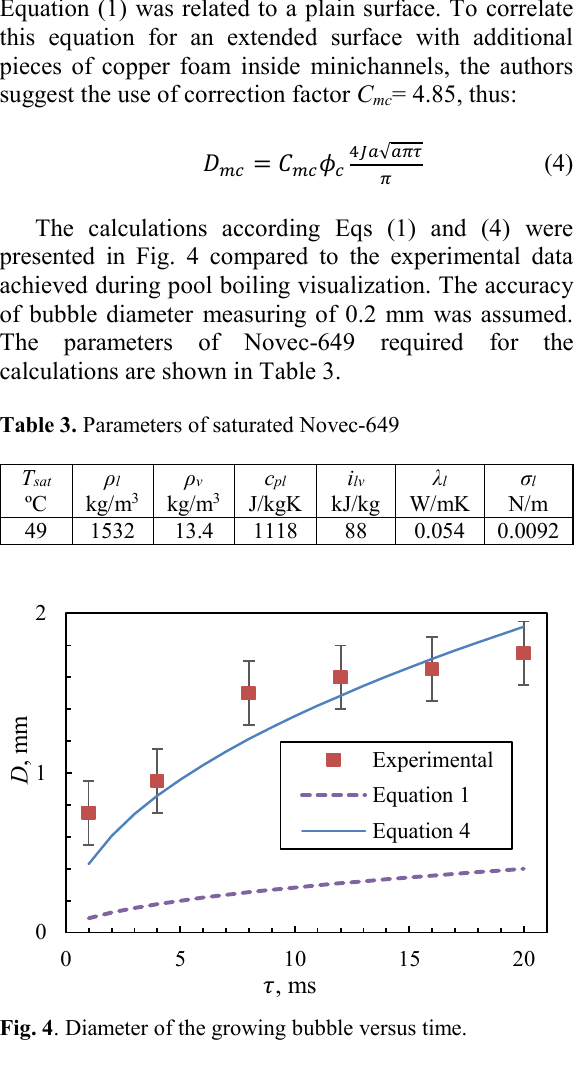
Fig. 3. Boiling curves for Novec-649, heat flux versus superheat.